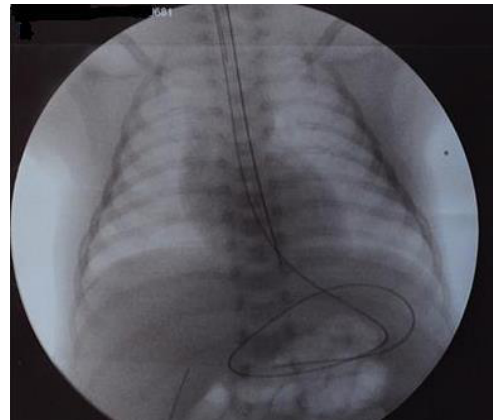
Figure 2: Chest radiograph showing the vascular guidwire which is entering the trachea, then passing through the tracheoesophageal fistula into the esophagus, and ending up curved in the